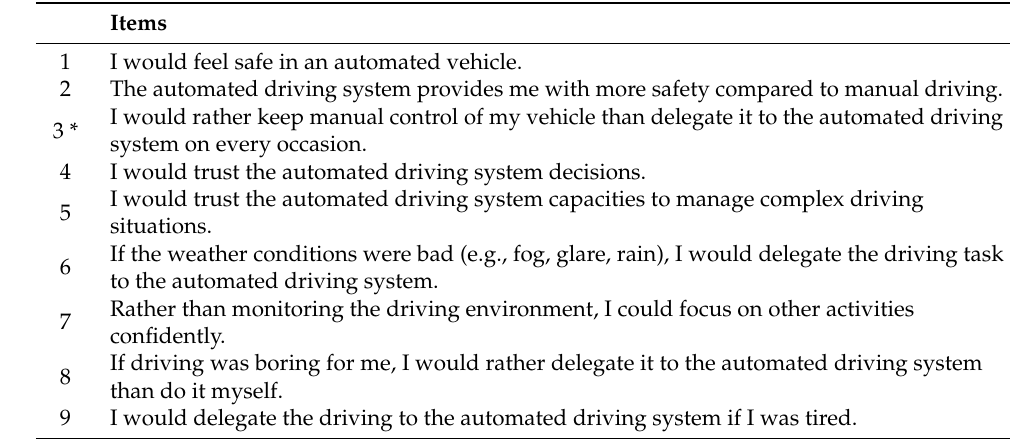
Table 1. Initial learned trust scale form [13]. * Answer was inverted for scoring.